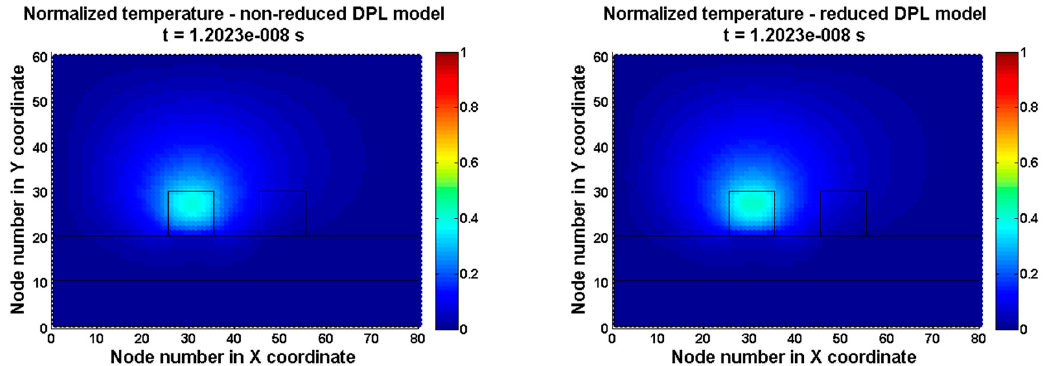
Figure 4. Comparison of normalized temperature rise in a cross-sectional area of the investigated MEMS structure obtained using reduced and non-reduced DPL model for t = 12.023 ns.